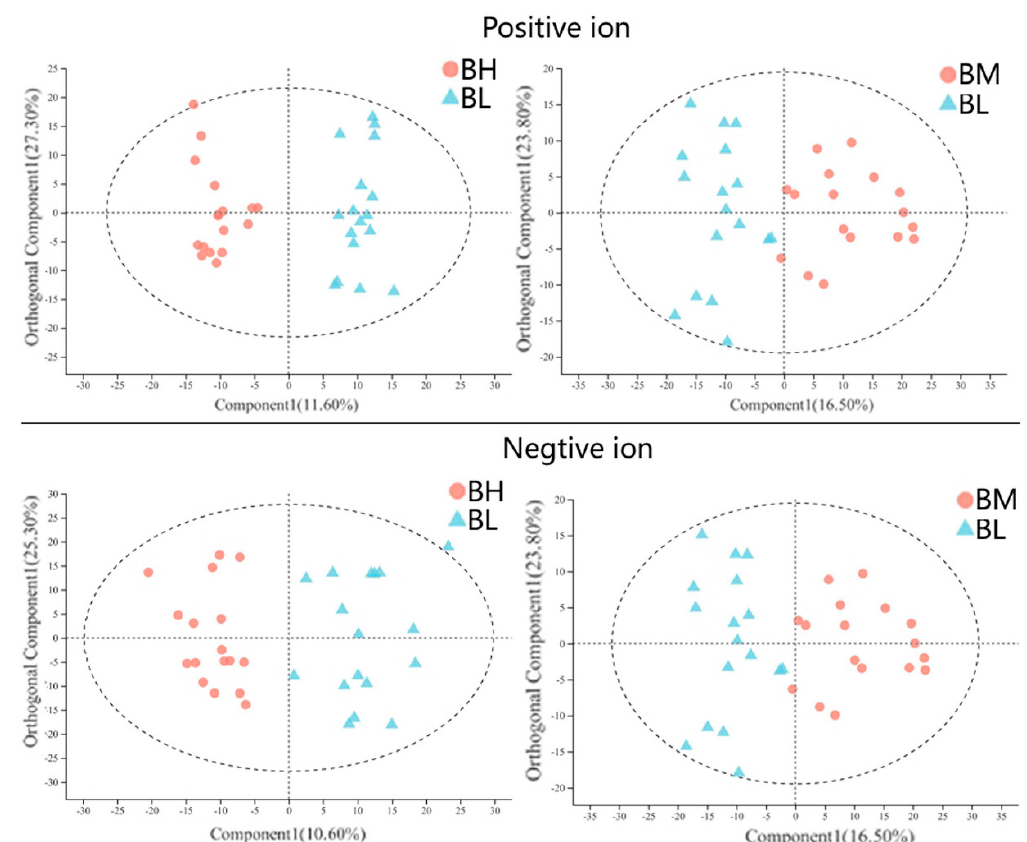
Figure 2. Orthogonal partial least-squares discriminant analysis (OPLS-DA) score plots for BH and BL groups, as well as for BM and BL groups, in positive-ion and negative-ion modes. Abbreviations: BH, high-level SHS exposure at the baseline; BM, medium-level SHS exposure at the baseline; and BL, low-level SHS exposure at the baseline. Table 2. Differential urinary metabolites at different levels of SHS exposure in children at the baseline. BH vs. BL BM vs. Metabolites